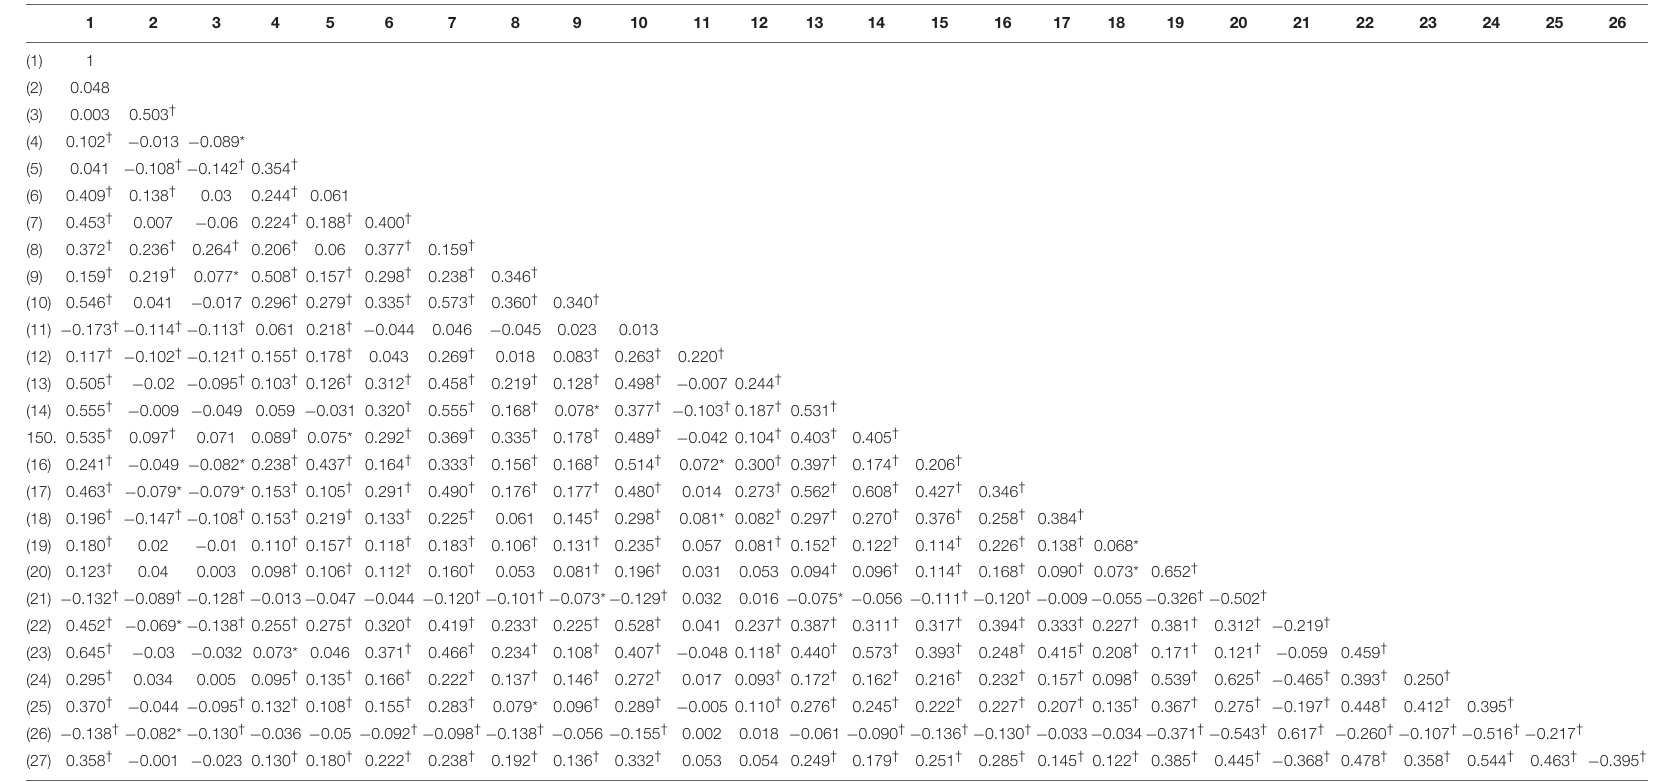
TABLE 2 | Bivariate correlations between ICT